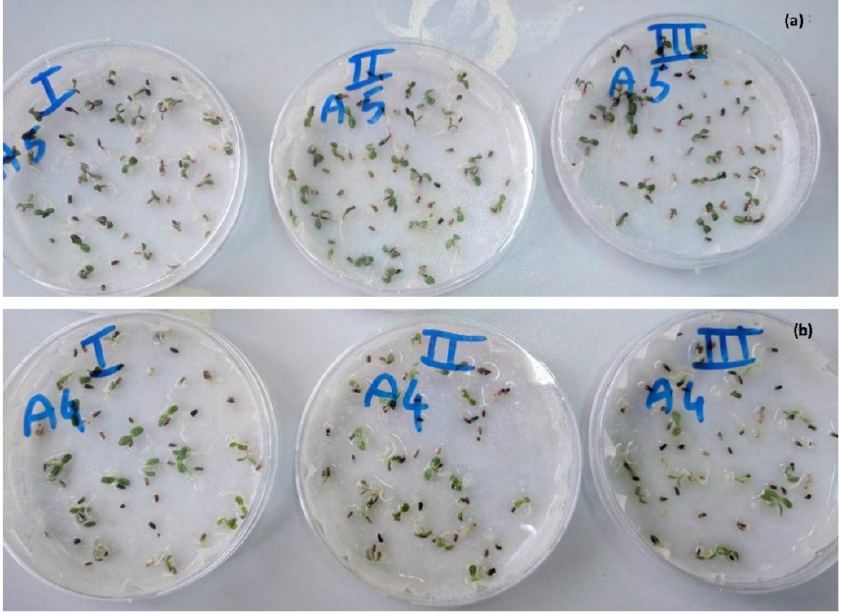
Figure 3. Test of the germinability in Petri dishes of Broccolo Natalino ( a ) and Mugnoli ( b )